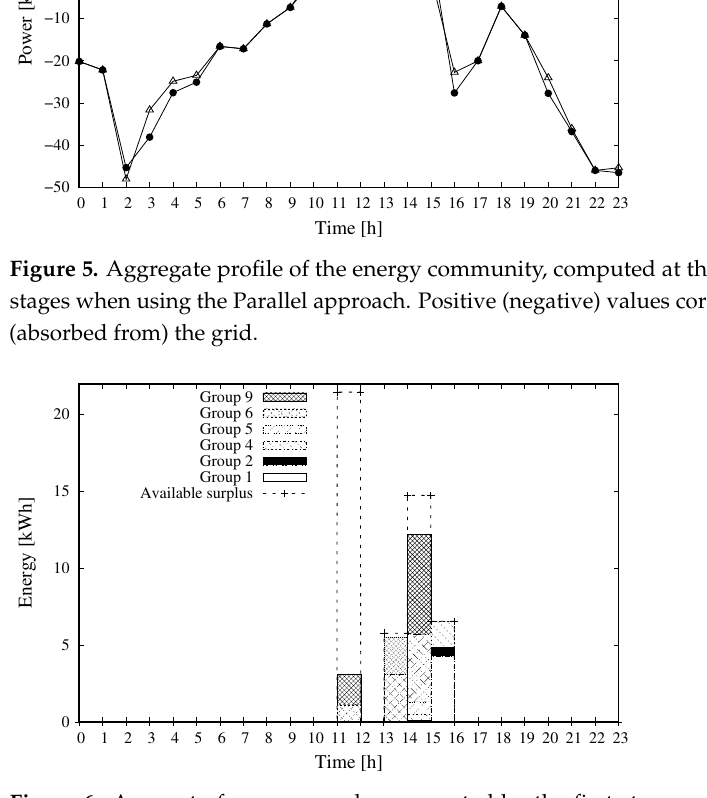
Figure 6. Amount of energy surplus computed by the first stage and amount of energy surplus redistributed to the groups by the second stage. Table 4. Energy cost incurred by the single groups and the community, after the first and second stages, when considering the energy exchanged with the external